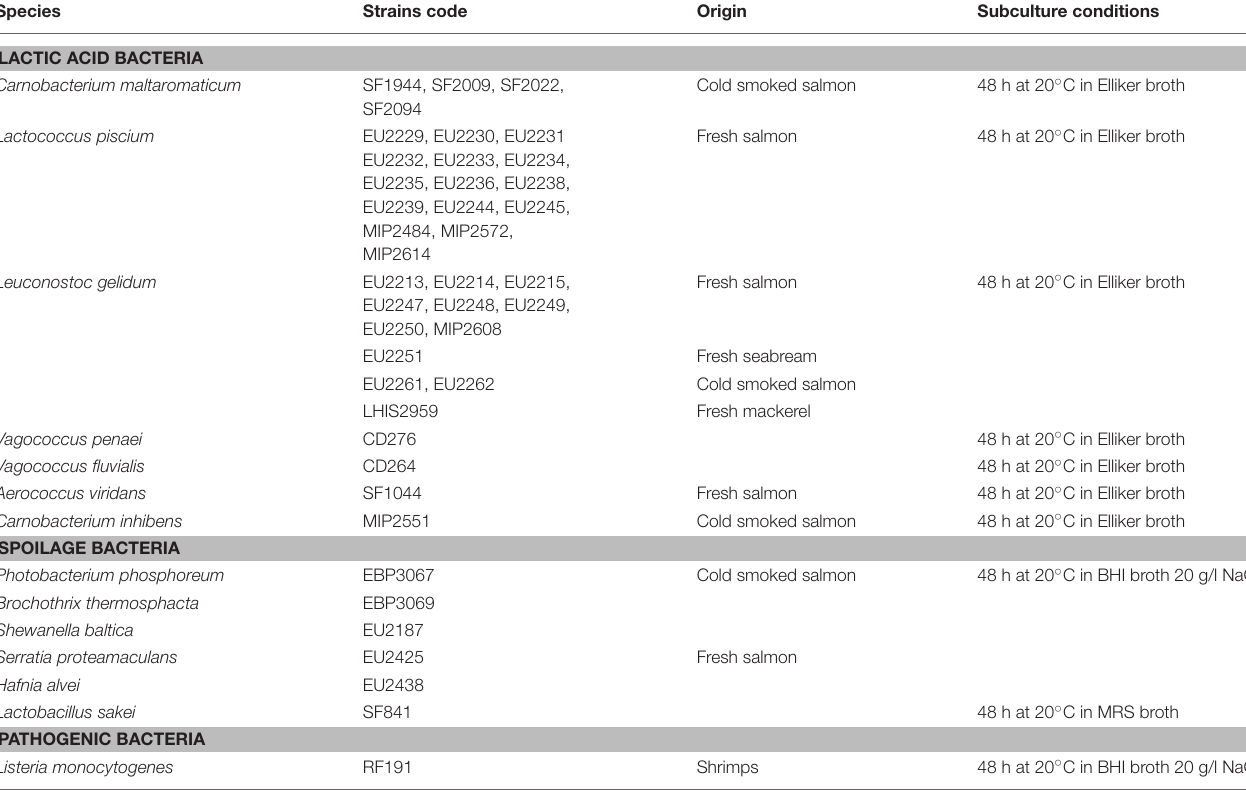
TABLE 1 | Lactic acid bacteria and target strains subculture conditions.